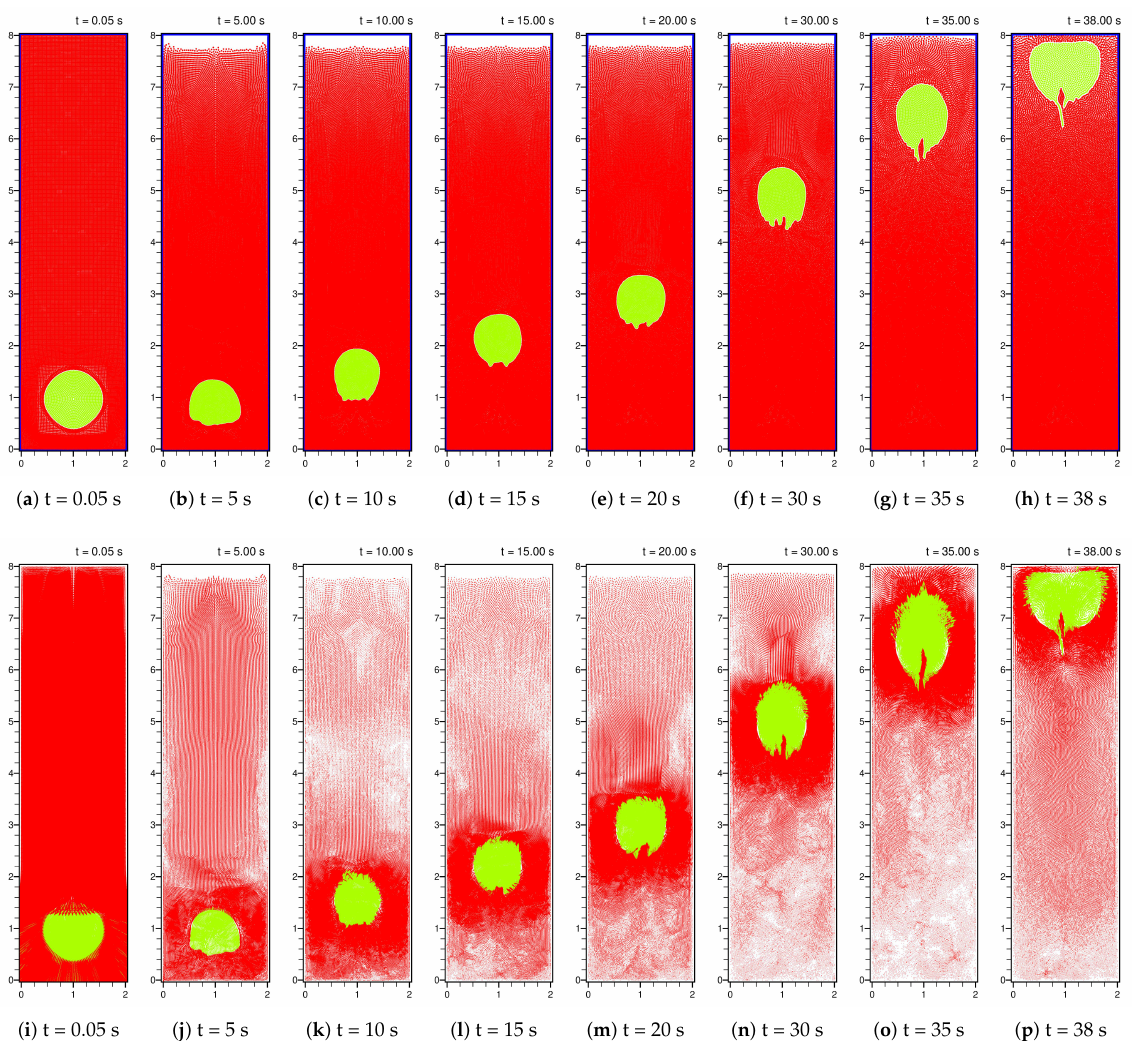
Figure 5. The evolution of one rising bubble ( a – h ) and corresponding velocity fields ( i – p ) with = density ratio ρ g ρ f